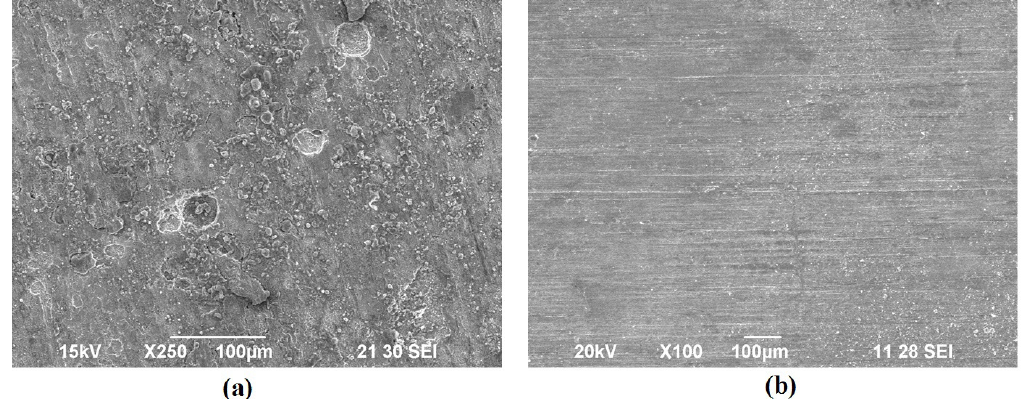
Figure 7. SEM monographs of mild steel specimen immersed in 1 M HCl solutions in the absence (a) and presence (b) of inhibitor. Table 4. Excess charge on MS electrode in 1N HCl and 1N H